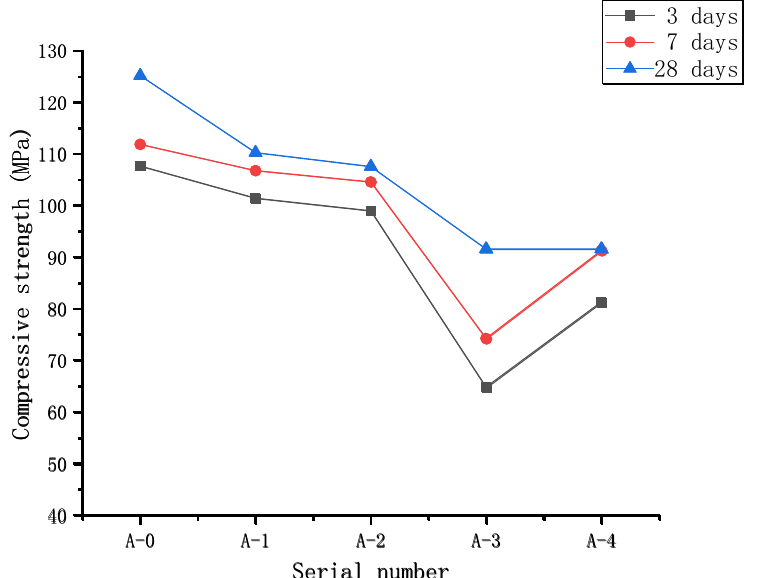
Figure 7. The unconfined compressive strength of RPC with WTSP replacing part of quartz sand. The downward trend of RPC strength with the increase in WTSP content is mainly due to the low water content in RPC slurries. The used water-reducing agent maintains the fluidity without adding water for pumping purposes. However, the WTSP has a large specific surface area. It absorbs water and leads to insufficient water for the hydration process of cementitious material, the dispersion of WTSP within the cement matrix is poor [34,35], decreasing the UCS of RPC [36,37]. In addition, there are certain impurities in the WTSP, and the mud content is significant. With the increase in the WTSP content, the increasing amount of impurities and mud in WTSP might decelerate the hydration process in RPC